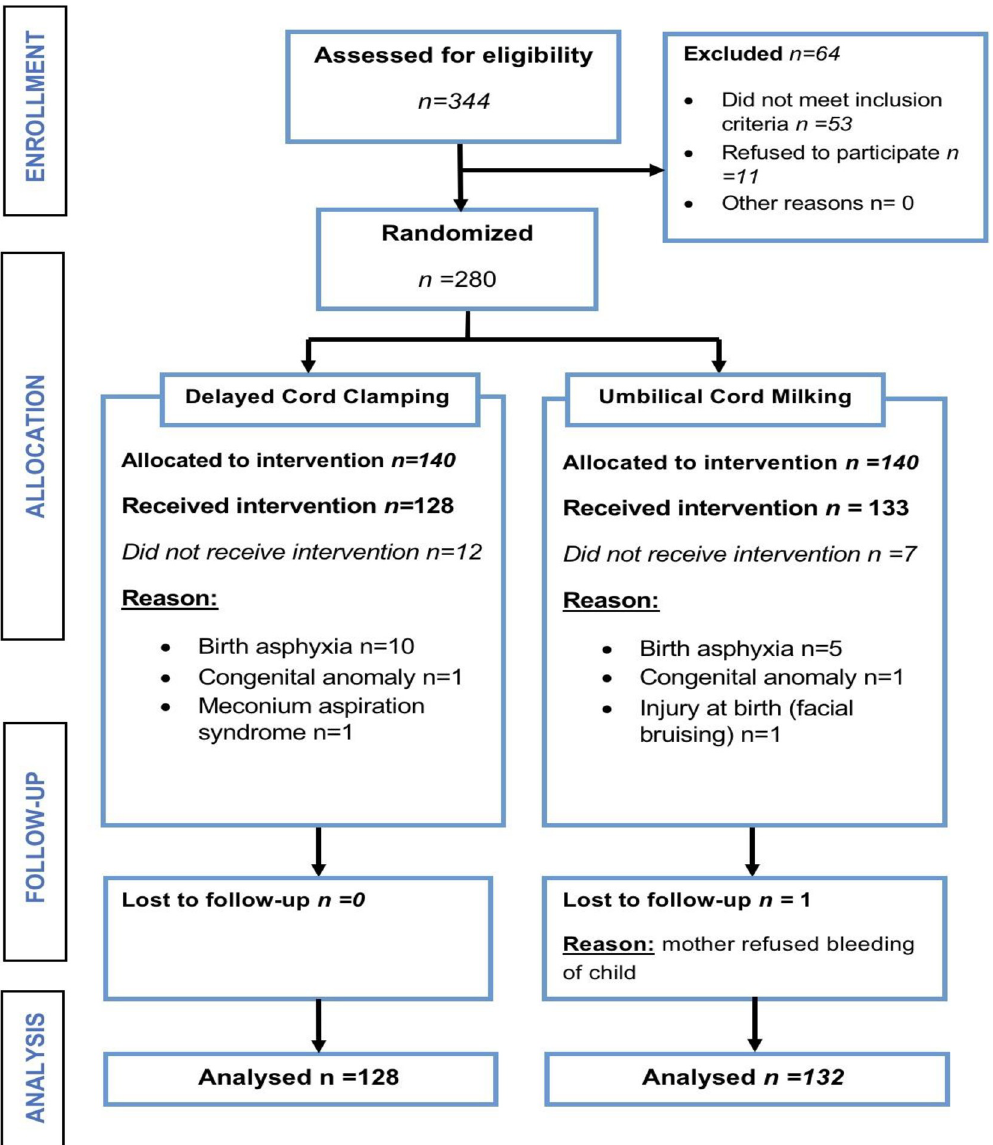
Fig 1. Study enrolment and follow-up of study participants who underwent umbilical cord milking versus delayed cord clamping between March 2018 to May 2019 at Kenyatta National Hospital.